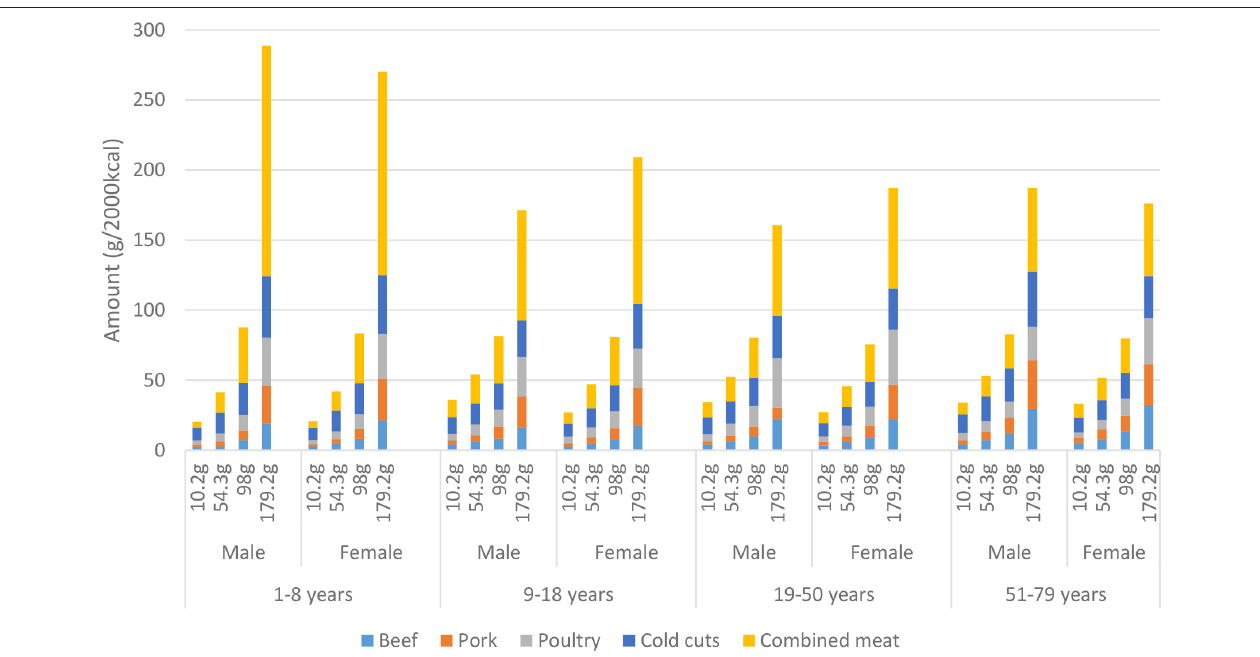
FIGURE 1 | Consumption per type of meat presented by mean total meat consumption per quartile (based on the total population), gender and age derived from the Dutch National Food Consumption Survey 2012–2016.